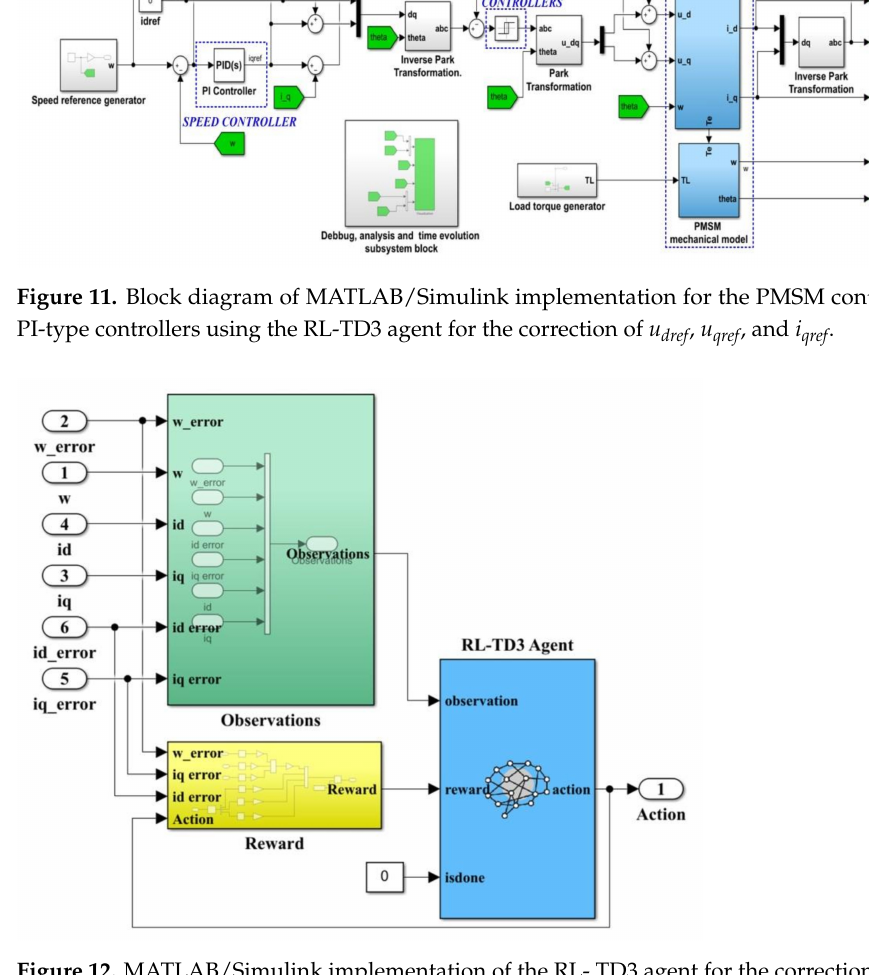
Figure 12. MATLAB/Simulink implementation of the RL- TD3 agent for the correction of u dref , u qref , and i qref